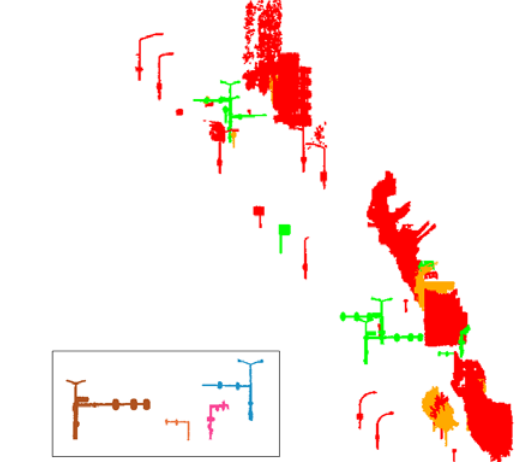
Figure 12 Correlation results on tree samples (inset). Components are coloured by correlation:>0.8 (green), >0.75 (orange) and <0.75 (red). Components with correlation lower than 0.7 are not